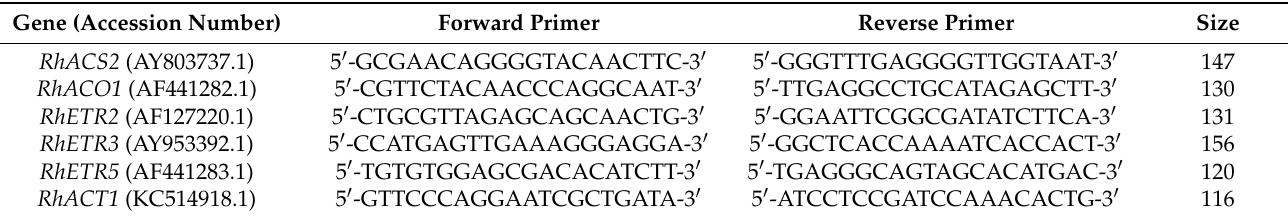
Table 1. Primer sequences used for qRT-PCR analyses in this